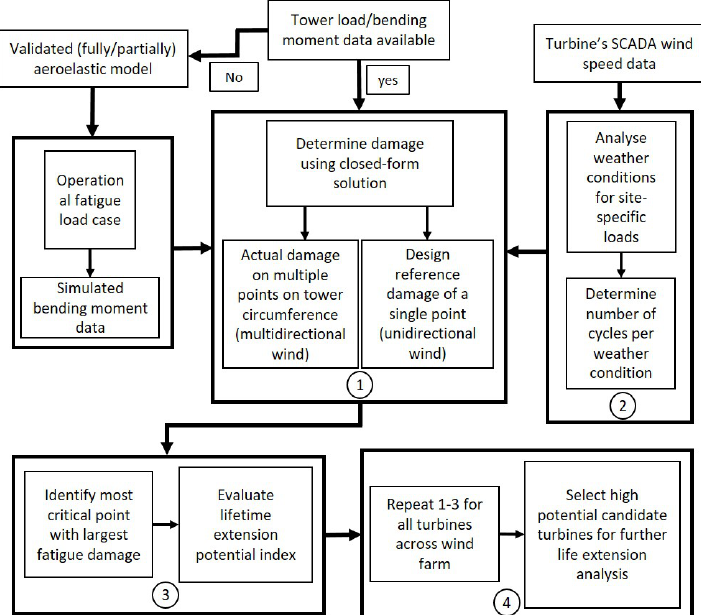
Figure 1. Flowchart of lifetime extension potential assessment